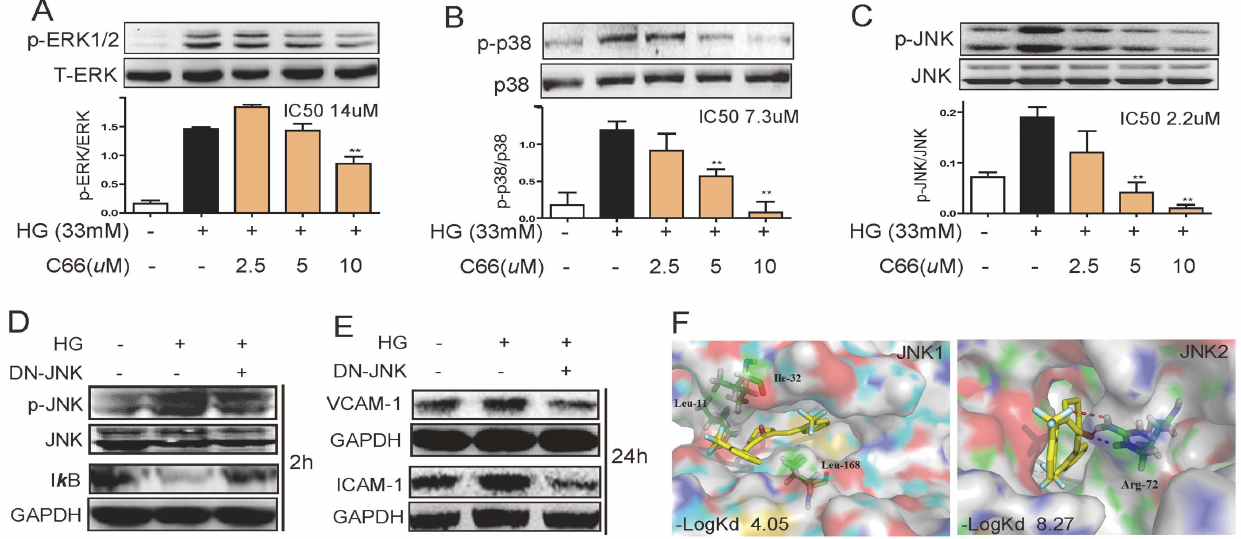
Figure 3. JNK may mediate the beneficial effects of C66. A-C ). C66 inhibited the phosphorylation of ERK1/2 (A), p38 (B) and JNK (C). The bar graphs show the normalized optical density as percentage of low glucose-treated group (* p , 0.05, ** p , 0.01). D&E). NRK-52E cells were transfected with dn-JNK plasmid or vector. Such process corrected glucose induced I k B activation (D) and reduced VCAM-1 and ICAM-1 productions (E). F). Two representative figures show molecular docking between C66 and JNK1 or JNK2, respectively. The binding scores (-log Kd) between C66 and JNKs were obtained using the docking software.